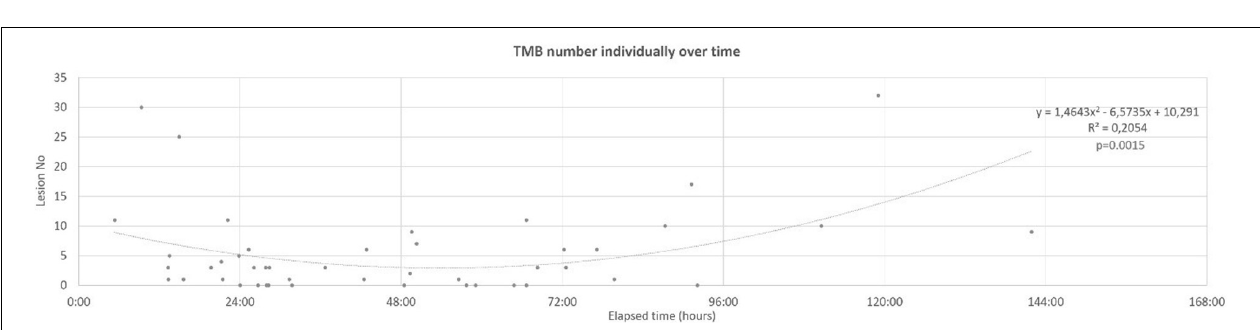
FIGURE 4 | Individual TMB number over time, fitted second-order polynomial trend line. TMB, traumatic